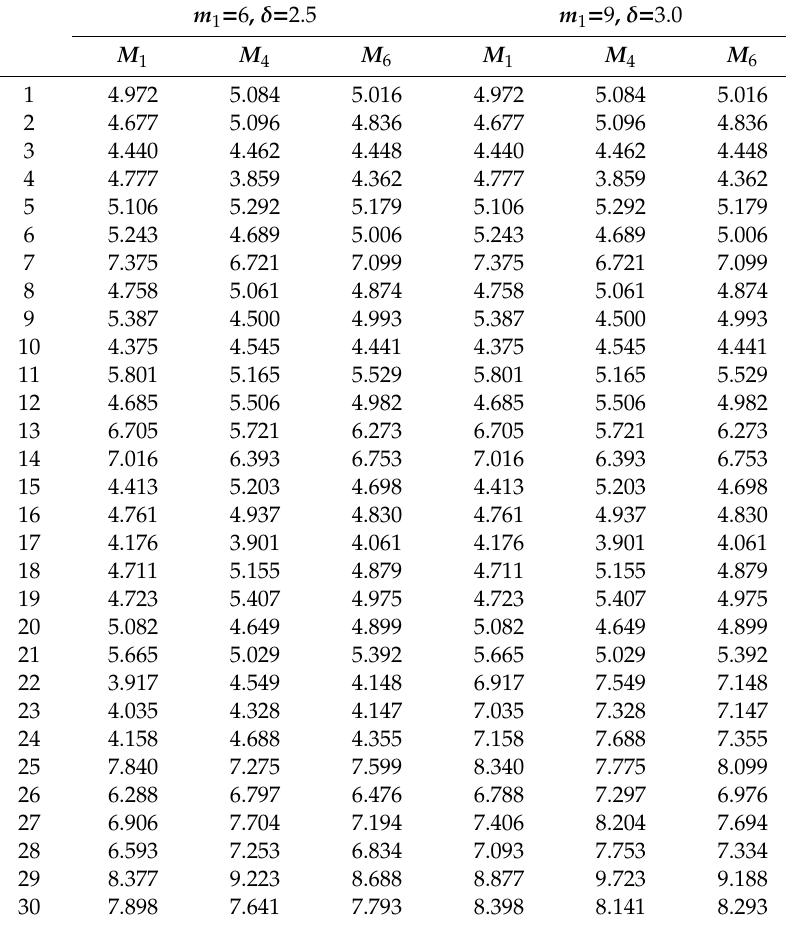
Table 4. Plotting statistics of the median charts based on M 1 , M 4 and M 6 for concrete data. m 1 = 6 , δ =